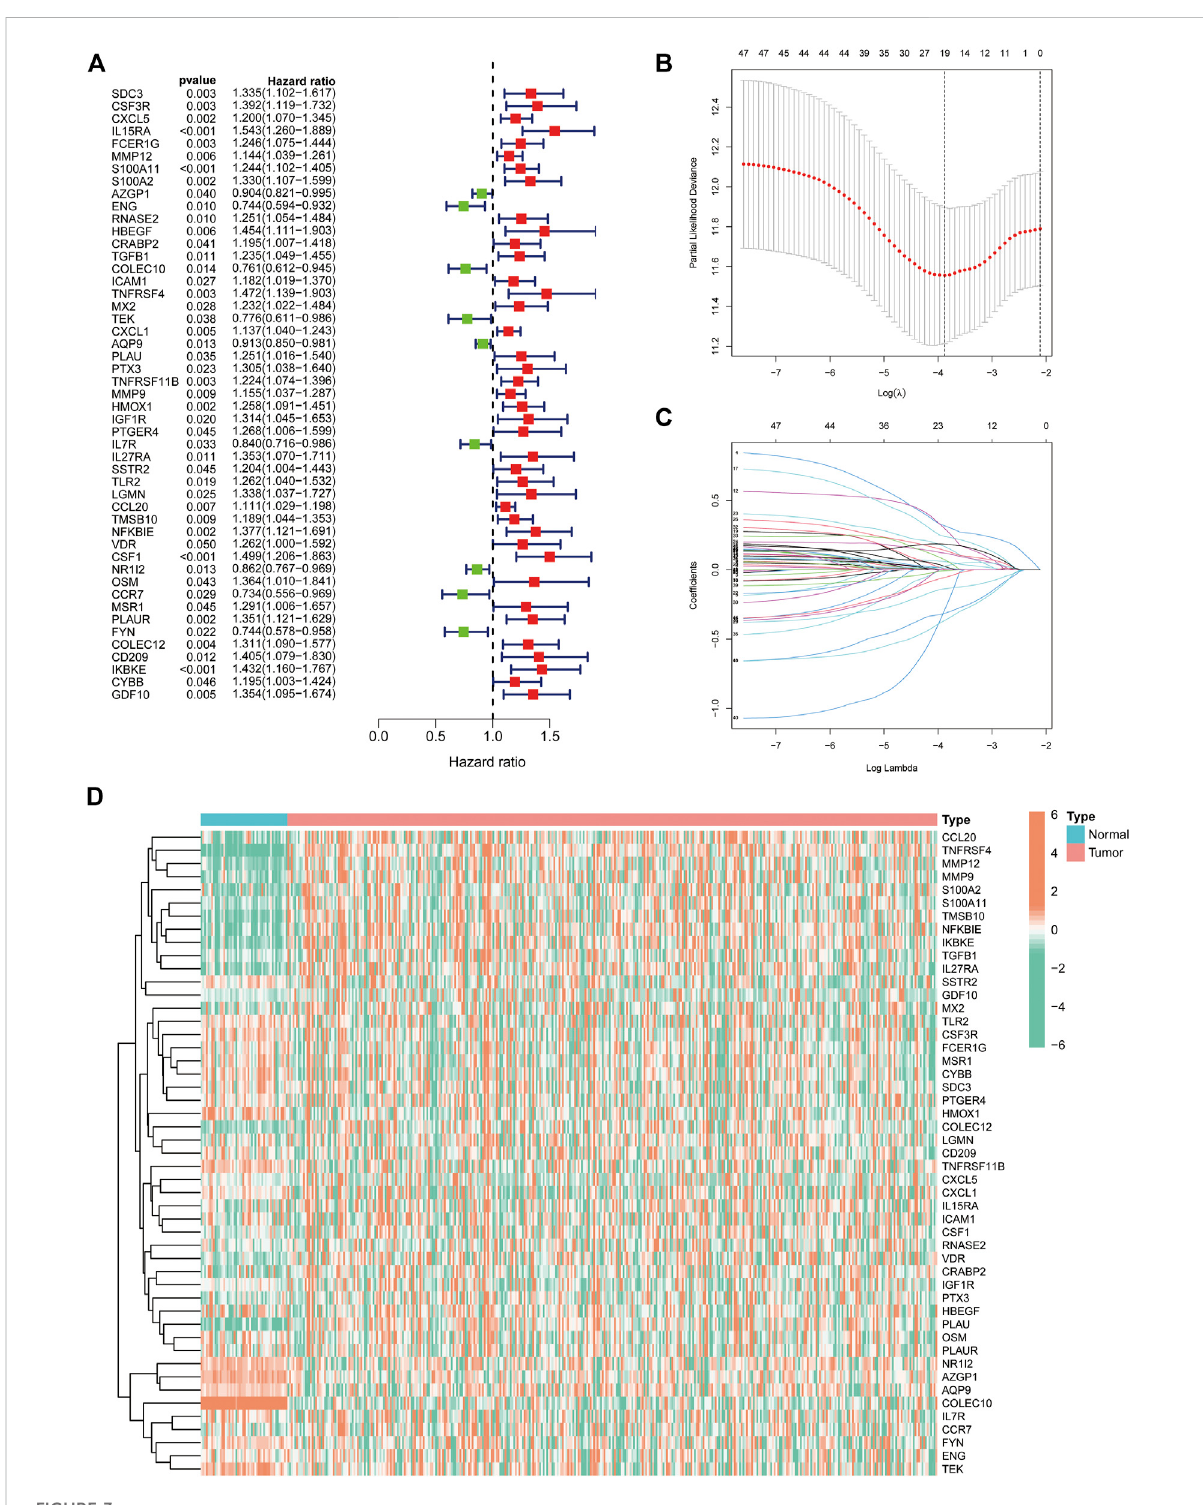
FIGURE 3 Identi fi cation of immune-related differentially expressed genes (DEGs) associated with prognosis for signature construction. (A) Forest plot of 49 immune-related DEGs signi fi cantly associated with overall survival in patients with hepatocellular carcinoma (HCC). (B,C) LASSO coef fi cient and partial likelihood deviance of the prognostic signature. (D) Heat map of 49 prognosis-related genes expressed in HCC tumour samples and normal